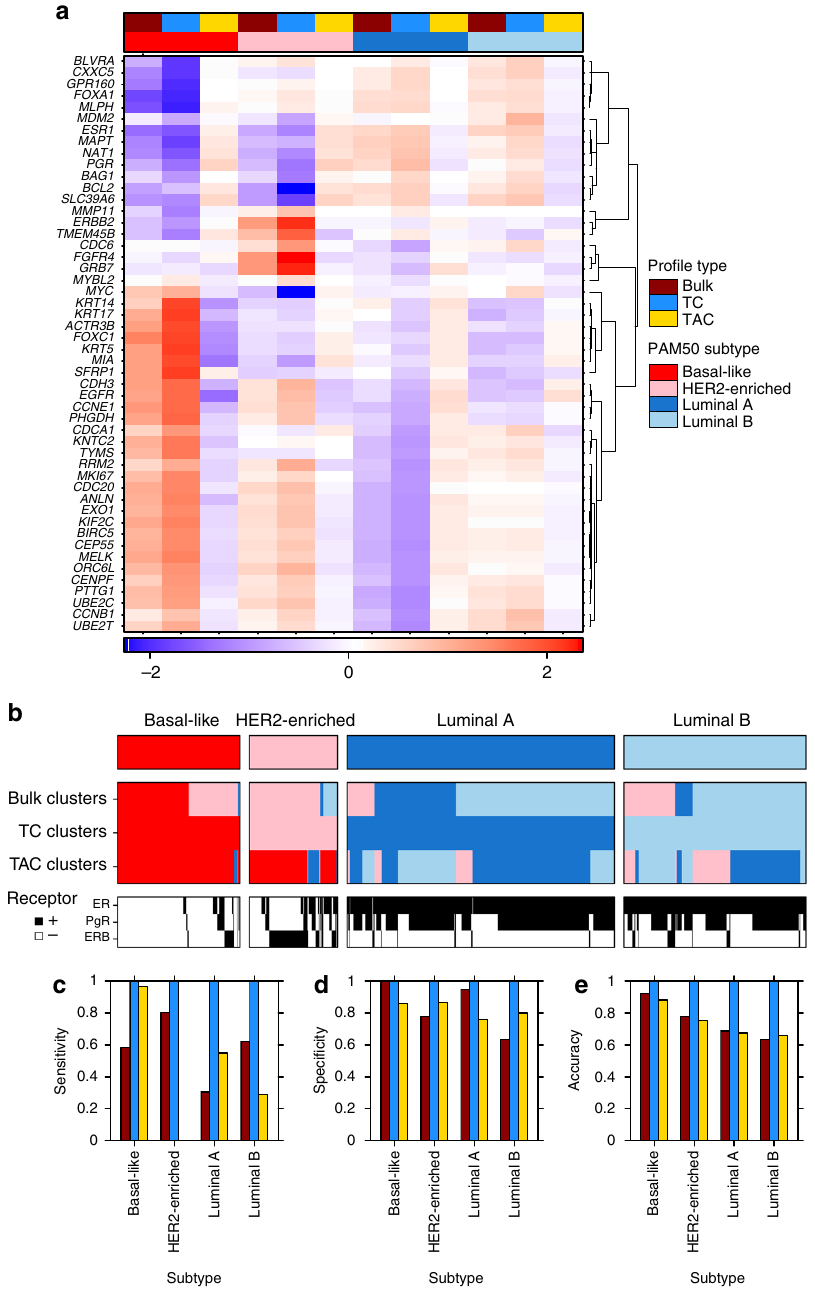
Fig. 2 PAM50 associations. For genes in the PAM50 biomarker, columns compare the average mRNA abundance for patients of each subtype. The mRNA abundance for each gene are scaled across all patient pro fi les for each pro fi le type a . Concordance between PAM50 subtypes and patients clusters based on highly variant genes (genes with standard deviation > 1.0 in at least one mRNA abundance type) are shown in b . PAM50 classi fi cations in the top bar are from the METABRIC paper. Receptor status of ERB, PgR and ER are also shown for each patient. Statistics describing classi fi cation alignment are shown in c , d and